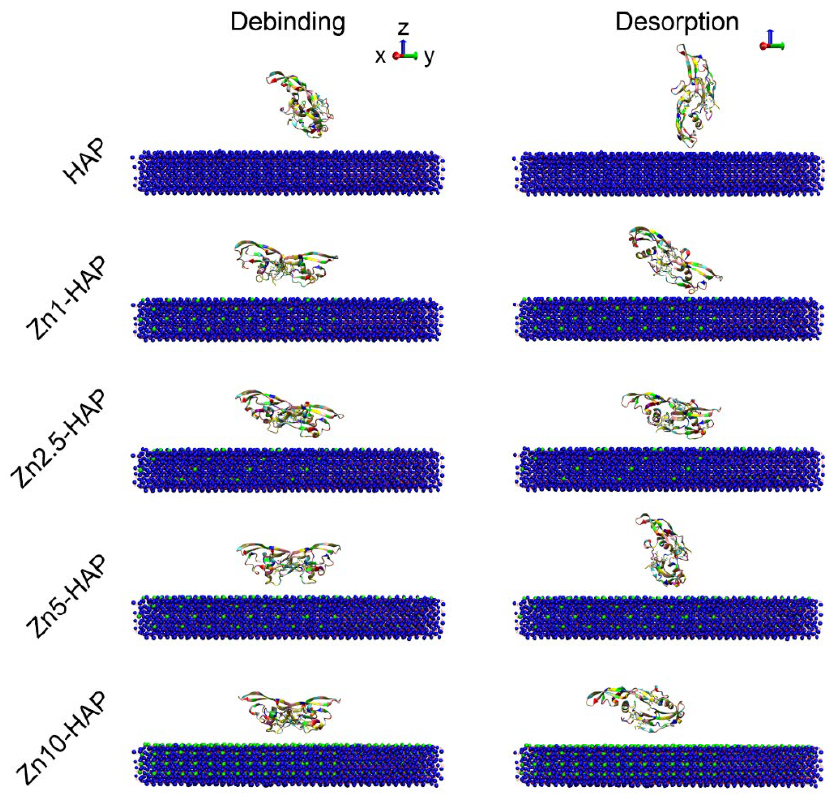
Figure 3. Snapshots of BMP-2 upon HAP and Zn-HAPs at the debinding state and desorption state. The conformations of BMP-2 at the debinding state were comparable to their adsorption states. However, the conformations of BMP-2 at the desorption states were remarkably changed.